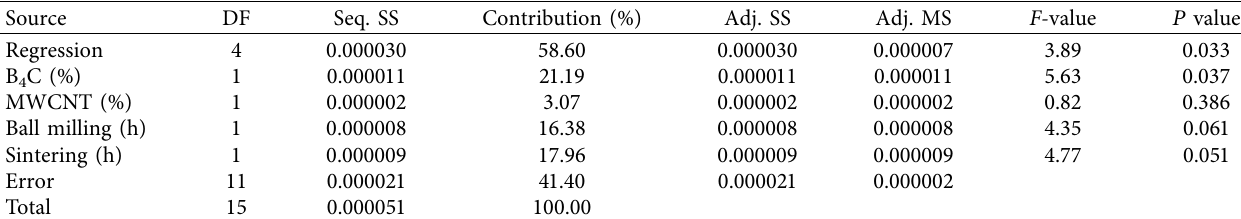
Figure 12. A moderate level (0.4%) of multiwall carbon